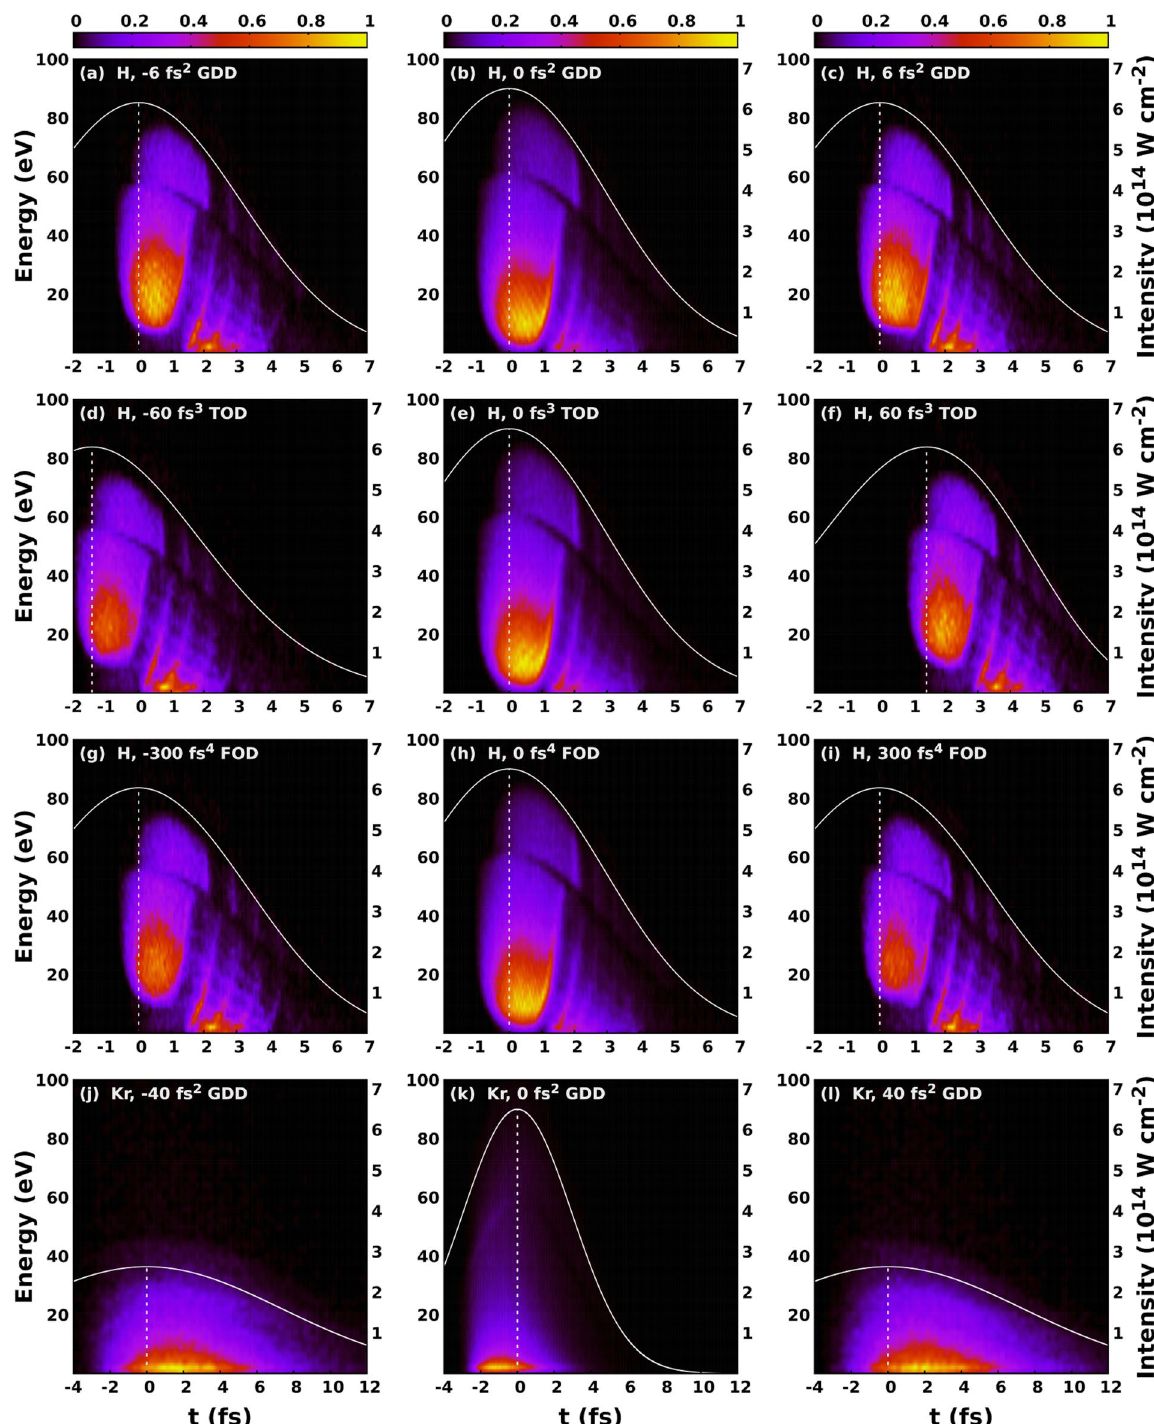
Figure 4. Contour plots of the normalized photoelectron distributions as a function of ionisation time and kinetic energy. The temporal envelope of the intensity of the laser pulse is depicted with a white line. The vertical dashed white line shows the moment of time when the intensity is maximal. Photoelectron distributions for hydrogen calculated with different GDD ( a–c ), TOD ( d–f ) and FOD ( g–i ). Photoelectron distributions for krypton calculated with different GDD ( j–l